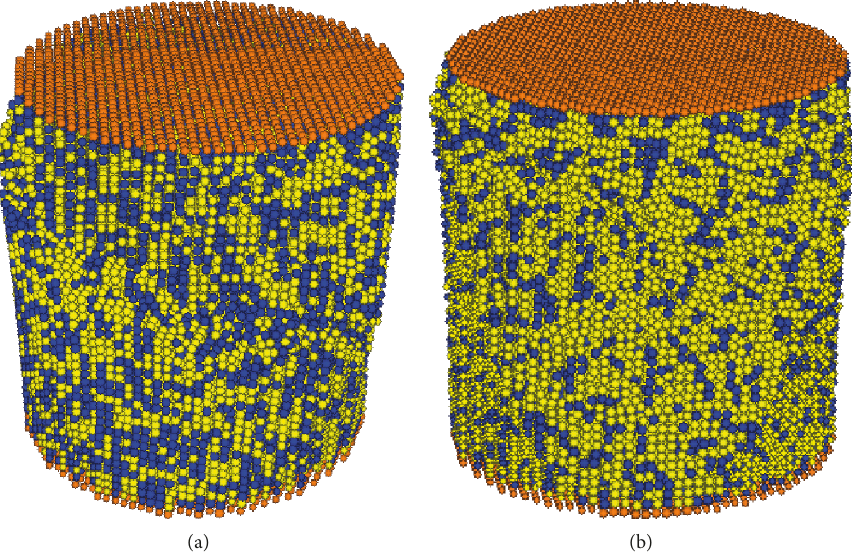
Figure 12: Results of two numerical model failure: (a) AC-13 and (b) SMA-13.